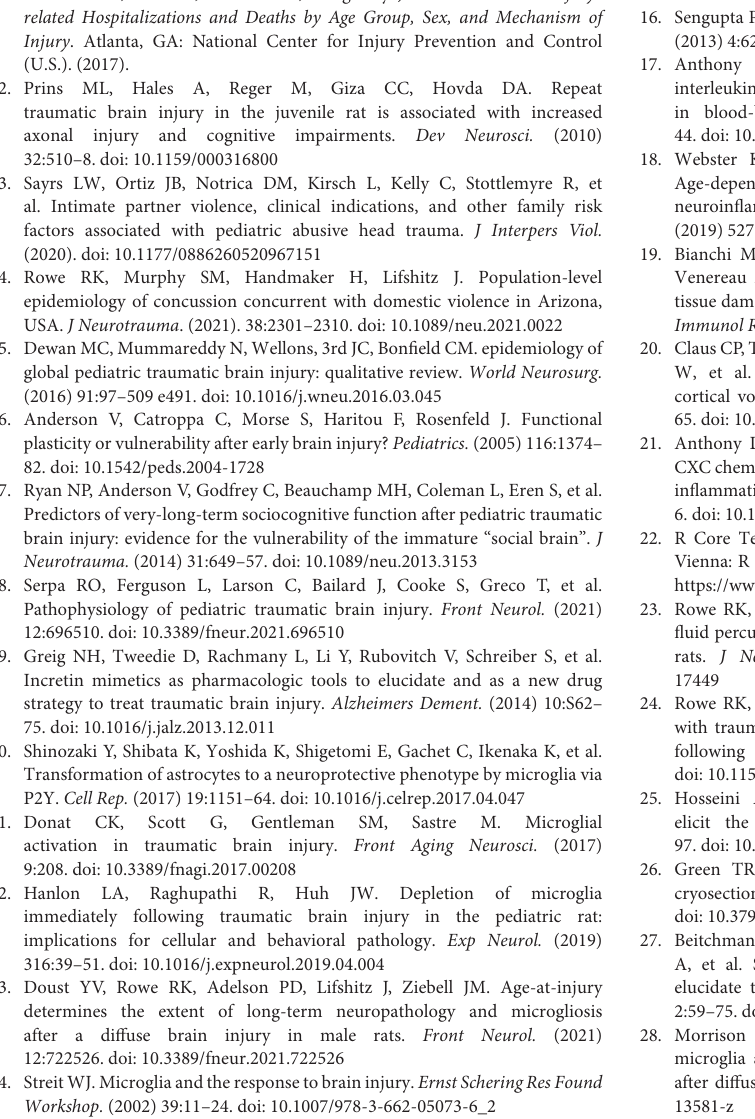
representative images were taken in the peri-injury cortex. Scale bars = 50 µ m (sham n = 39, TBI n = 35). Supplementary Figure 2 | Iba1 stained microglia in the perirhinal cortex at 2h (H), 1 day (D), and 25D post-injury compared to uninjured shams at 7D. All representative images were taken in the perirhinal cortex. Scale bars = 50 µ m (sham n = 39, TBI n = 35). Supplementary Figure 3 | GFAP stained microglia in the peri-injury cortex at 2h (H), 1 day (D), and 25D post-injury compared to uninjured shams at 7D. All representative images were taken in the peri-injury cortex. Scale bars = 50 µ m (sham n = 39, TBI n = 35). Supplementary Figure 4 | GFAP stained microglia perirhinal cortex at 2h (H), 1 day (D), and 25D post-injury compared to uninjured shams at 7D. All representative images were taken in the perirhinal cortex. Scale bars = 50 µ m (sham n = 39, TBI n =